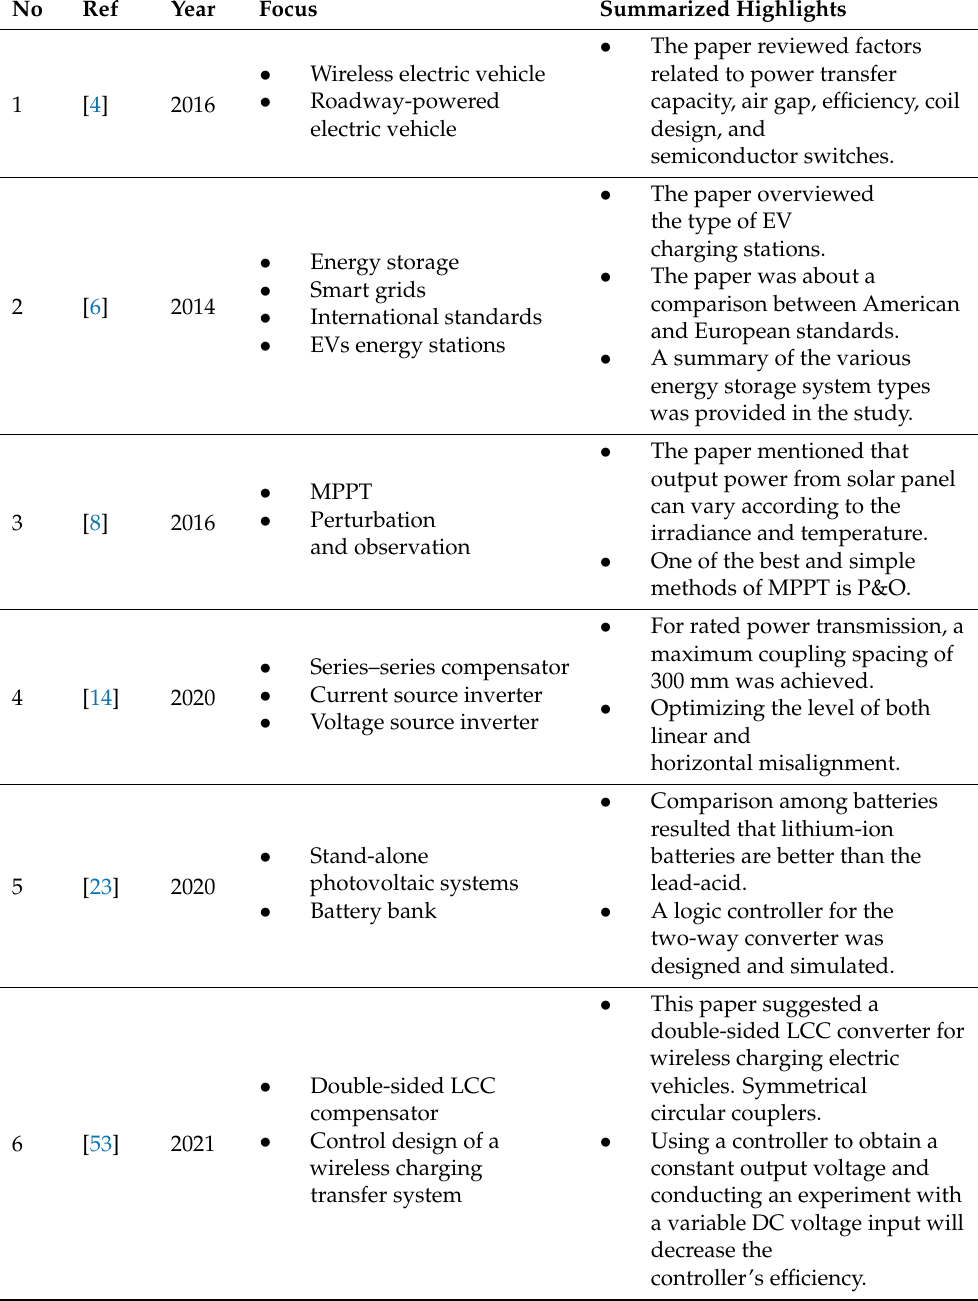
Table 5. Summary of literature review on WPT